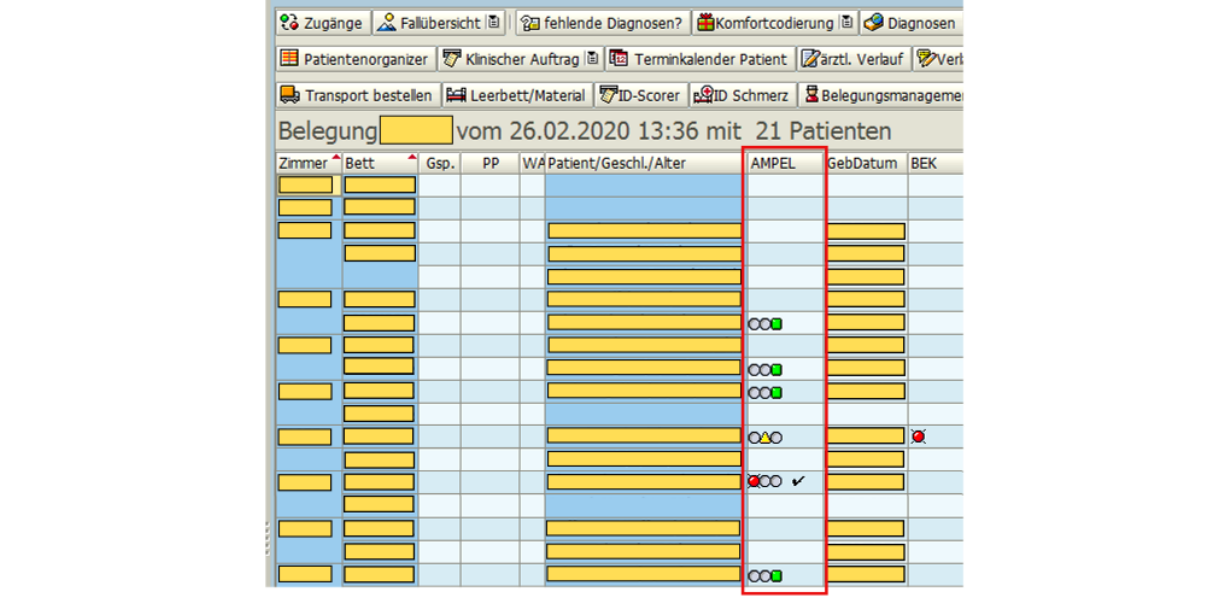
Figure 2. Screenshot of the SAP R/3 visual interface with highlight on the dedicated AMPEL column, with all three possible colors (summary report) displayed: green, yellow, or red.